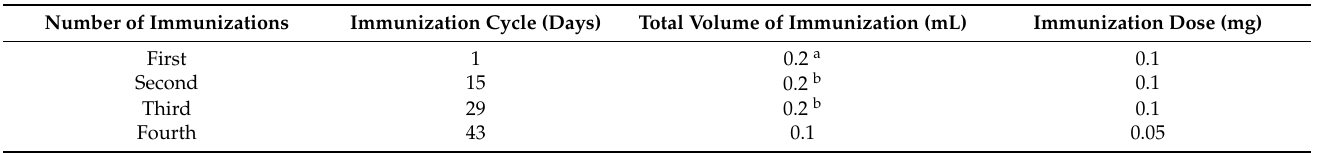
Table 1. Immunization strategy in